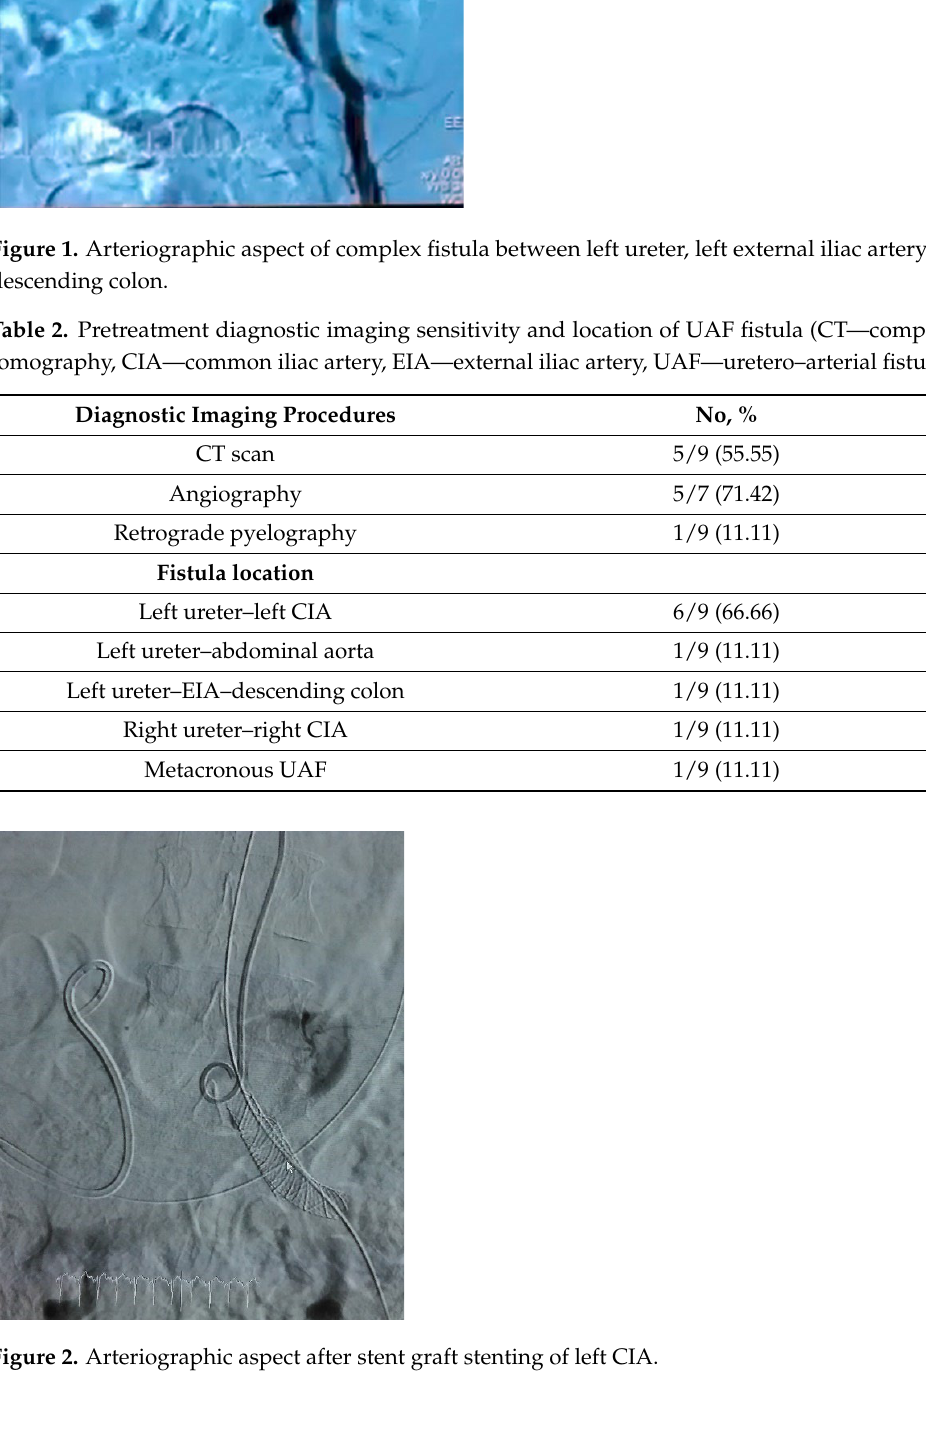
Table 2. Pretreatment diagnostic imaging sensitivity and location of UAF fistula (CT—computed